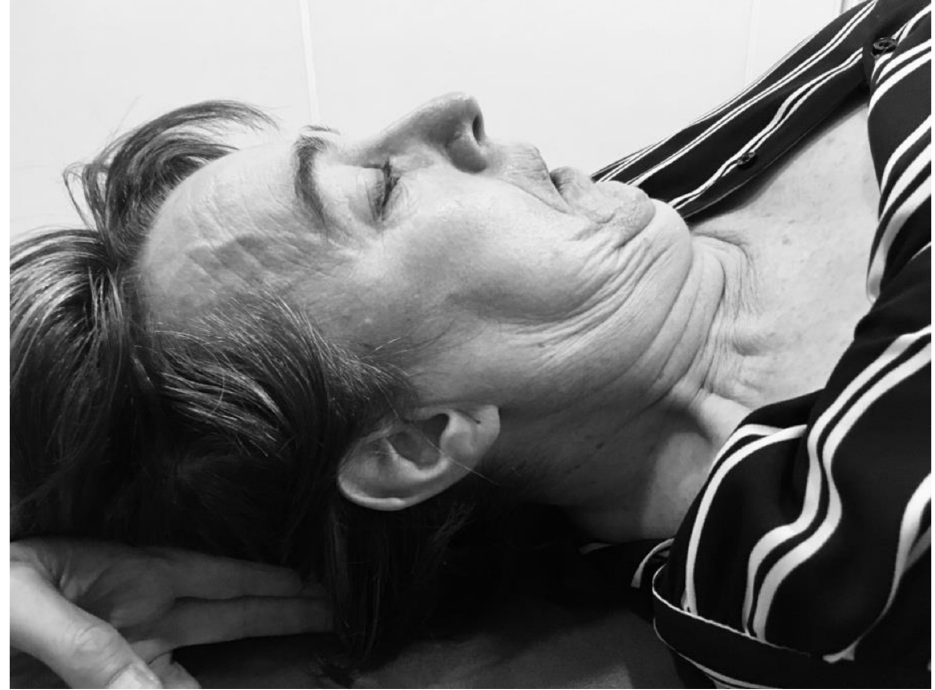
Figure 3. Deep cervical flexor endurance test description over the neck